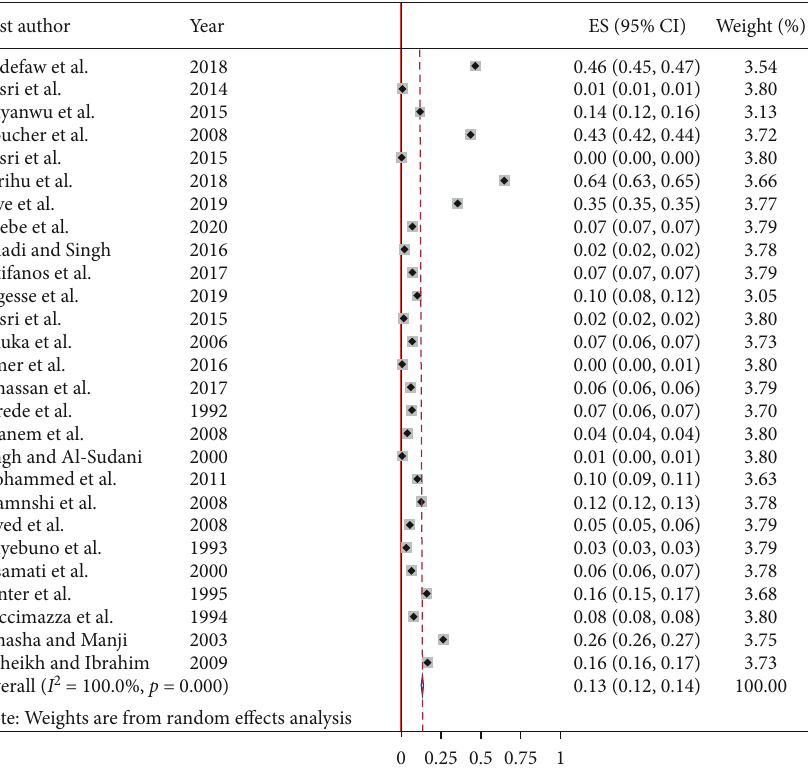
Figure 2: Forest plot showing the pooled prevalence of spina bifida in Africa, 2020.